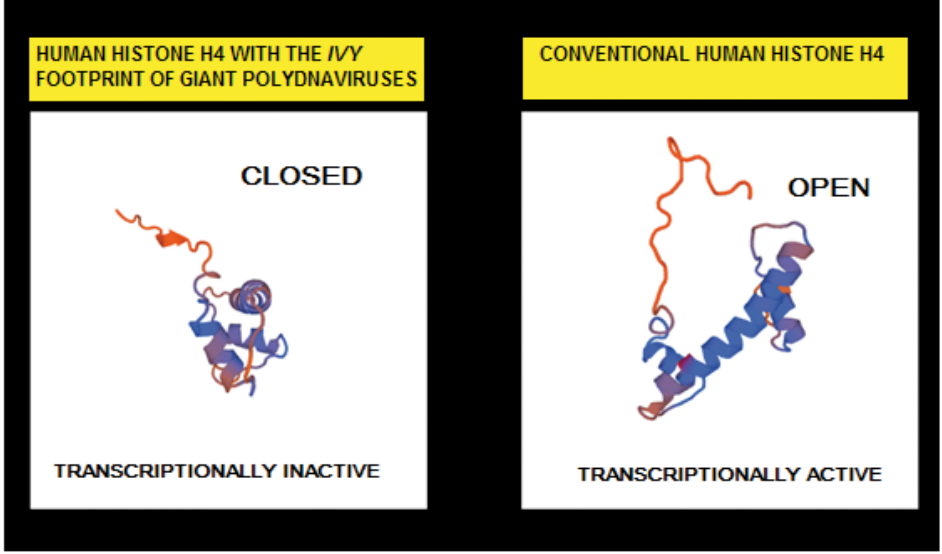
Figure 13. The newly identified human cellular structures display both canonical and histone H4 with an ancestral viral footprint. 3D protein structure models generated by SWISS-MODEL suggests that the human Mimivirus-like structures have a role in the regulation of transcription. The histone H4 with the IVY pattern have a closed transcriptionally inactive conformation. The canonical human histone H4 have an open conformation that is transcriptionally